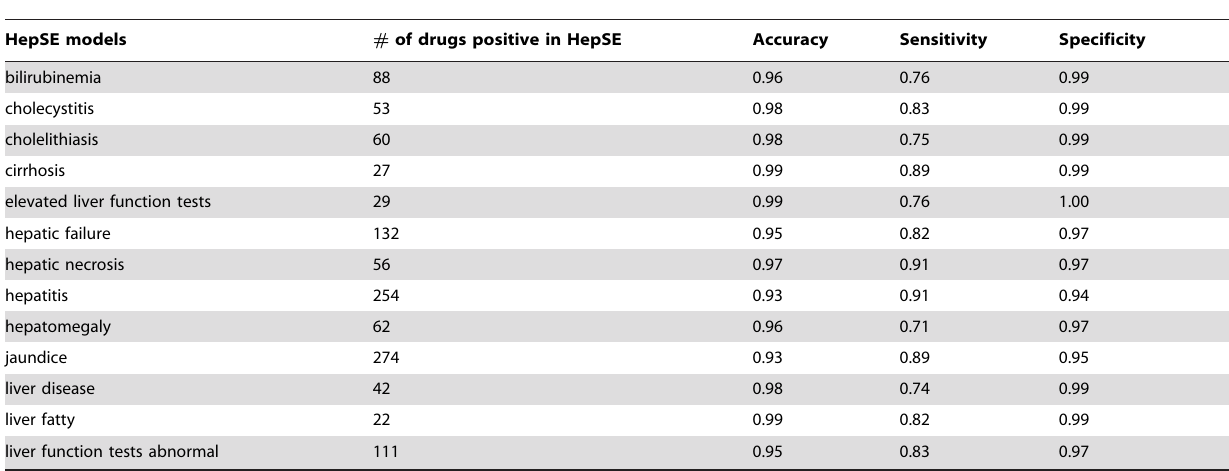
Table 1. Performance of leave-one out cross-validation for the 13 HepSE models.